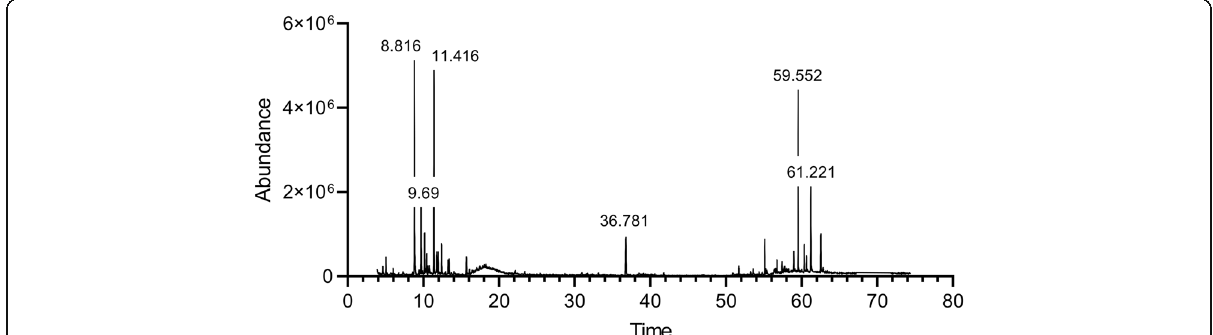
Fig. 6 Extract composition elucidation by GC-MS